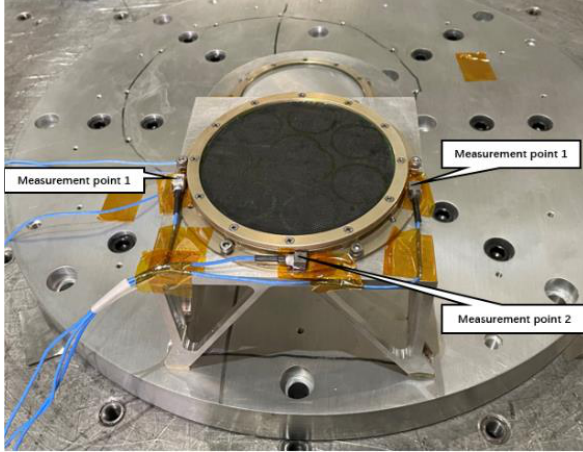
Figure 6. Layout of mechanical measurement points.